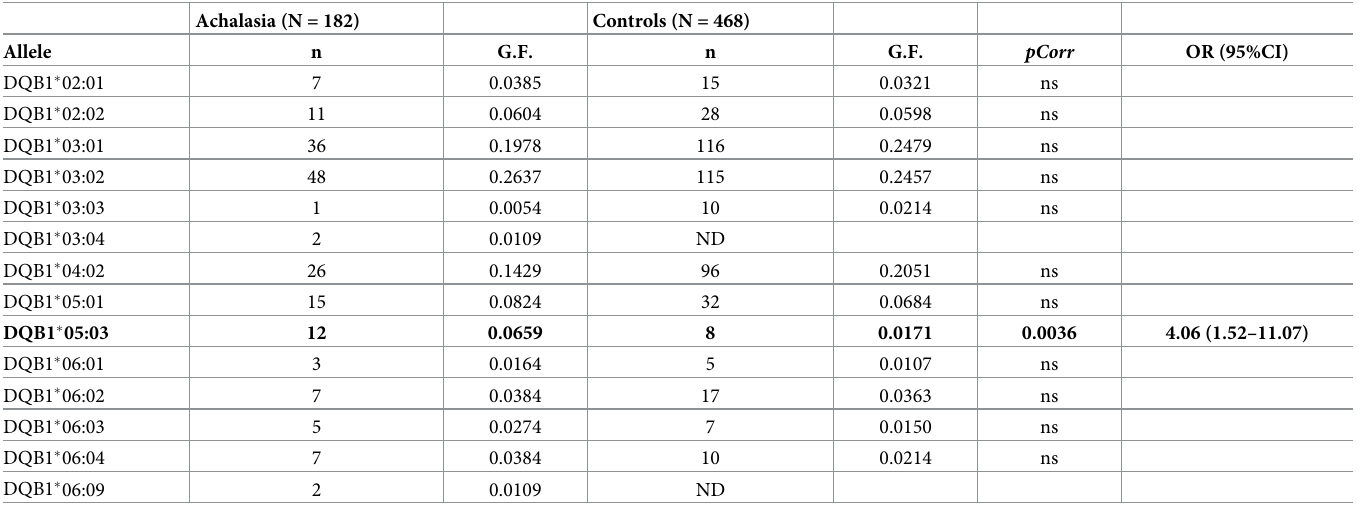
Table 4. Gene frequencies of HLA-DQB1 in achalasia patients and healthy